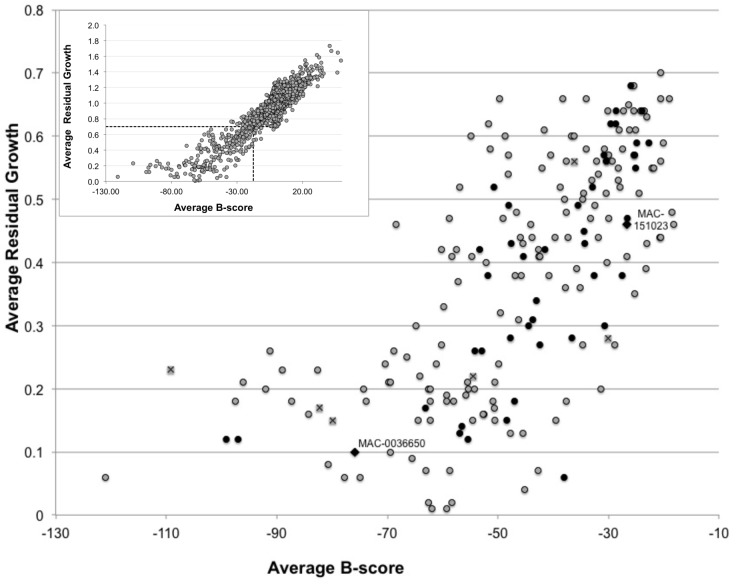
Overview of the primary screen results.The average residual growth of each compound is plotted against the Average B-score. The inset shows the application of an average residual growth cutoff of 0.70 and a B-Score cutoff of –17.5, (dashed line) to the whole screening campaign, which identified 206 Bce bioactives. The large scatter plot shows the 206 primary actives. For comparison reasons, 6 known antibiotics, are denoted with crossed rectangles, ceftriaxone sodium, (-121, 0.06); minocycline, (-109, 0.23); metampicilin, (-80.7, 0.08); chloramphenicol, (-68.8, 0.26); ciprofloxacin, (-35, 0.36); trimethoprim, (-29.6, 0.62). The two Bce bioactives with the most promising properties are indicated with diamonds and labeled.